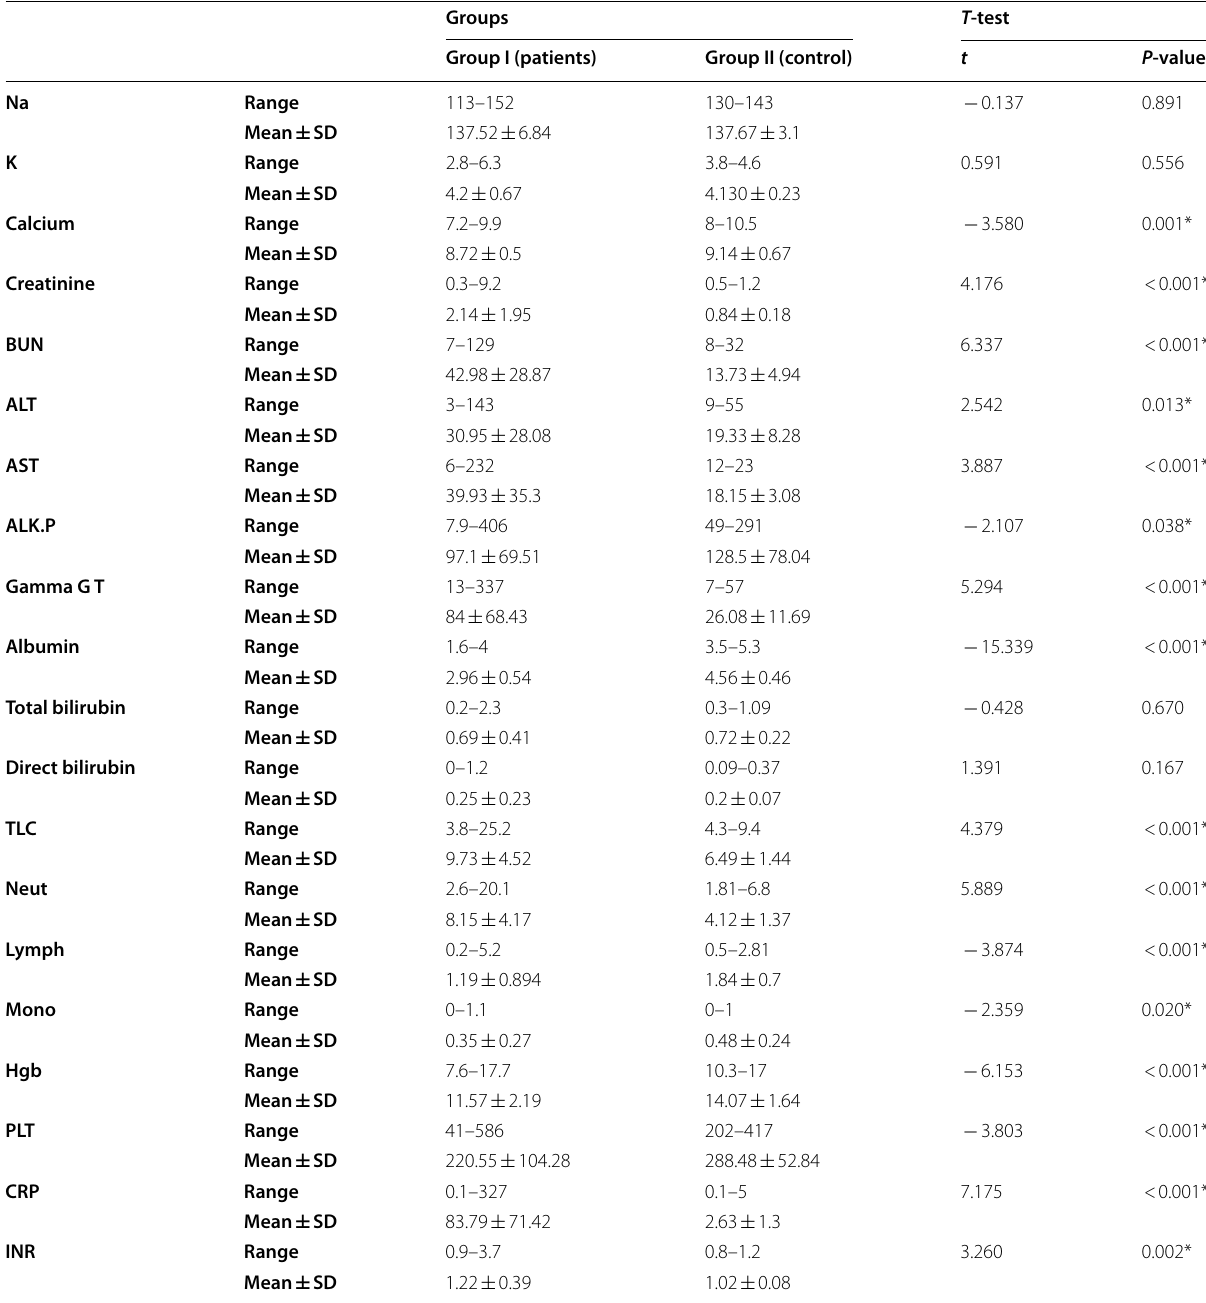
Table 1 Laboratory data of patients and control